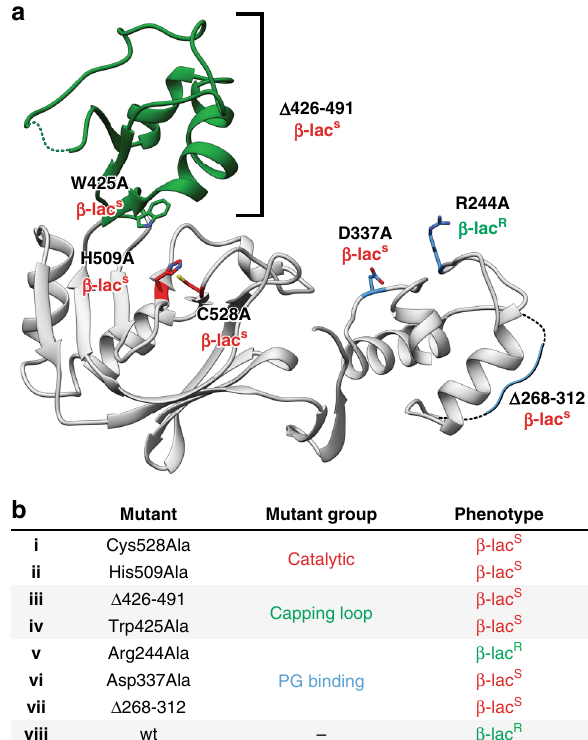
Fig. 5 In vivo assay of YcbB mediated beta-lactam resistance. a Various replacements and deletions of the catalytic residues (in red), capping loop region (in green) and PG binding domain (in blue), mapped onto the catalytic and PG domains of YcbB. Replacements retaining YcbB mediated beta-lactam (ampicillin and ceftriaxone) resistance are denoted as β -lac R , while replacements and deletions resulting in beta-lactam (ampicillin and ceftriaxone) susceptibility are denoted as β -lac S . b Replacements and deletions of pTK2( ycbB ) (i – viii) are listed with their resulting